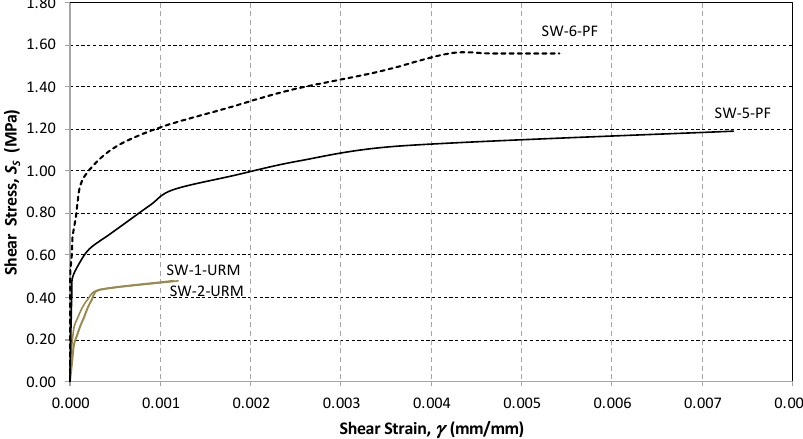
Figure 15. Shear stress versus shear strain plot (half-size panels).